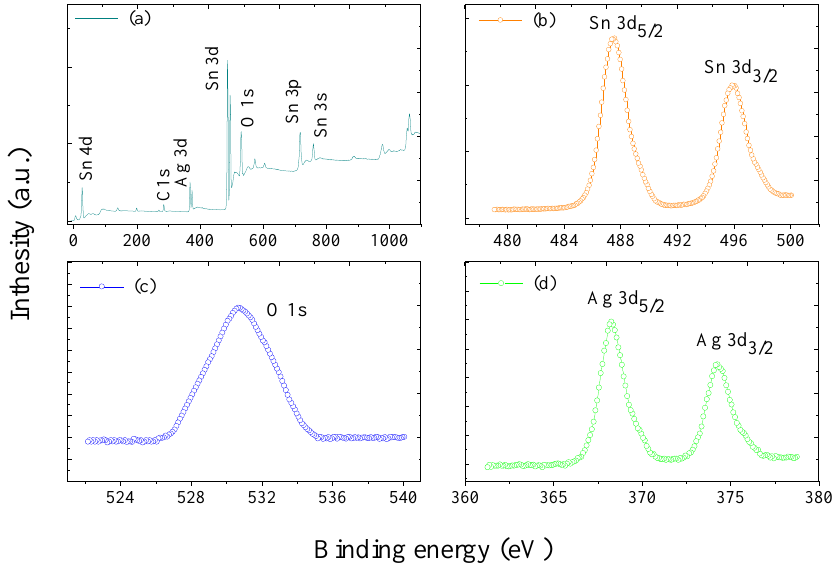
Figure 5. XPS survey spectra of 3 at.% Ag-doped SnO 2 nanospheres ( a ) full; ( b ) Sn 3d; ( c ) O 1s; ( d ) Ag 3d.